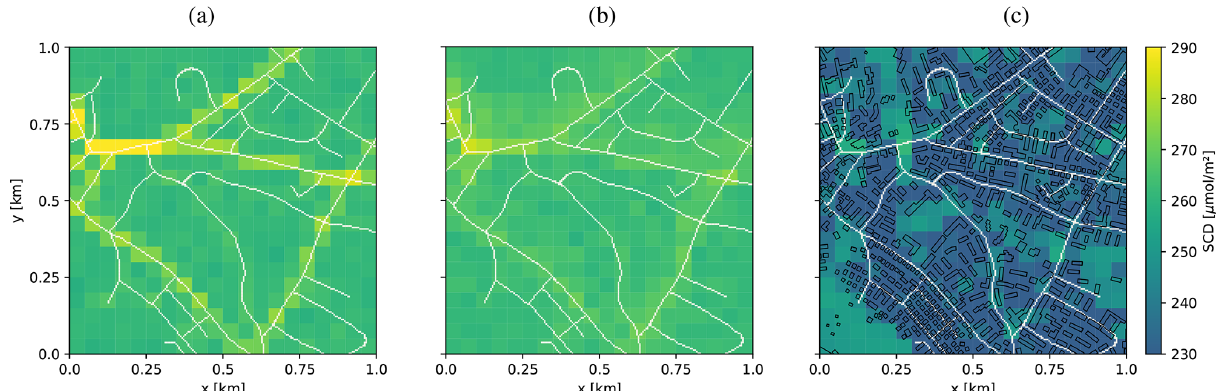
Figure 9. SCDs for simulations with a SAA of 0 ◦ with 1D-layer AMFs (a) and 3D-box AMFs simulation without (b) and with (c) buildings. The roads are drawn in white and the building contours in black for the simulation with